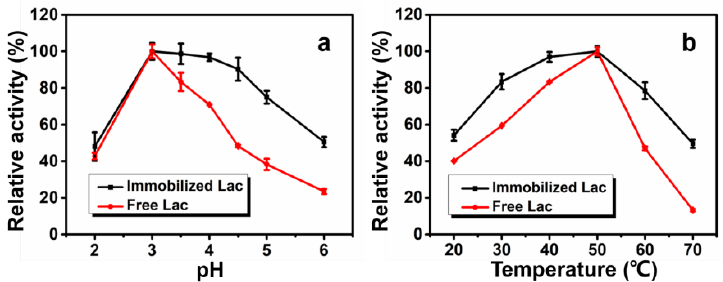
Figure 3. Effects of pH ( a ) and temperature ( b ) on Lac activity. Figure 3. E ff ects of pH ( a ) and temperature ( b ) on Lac